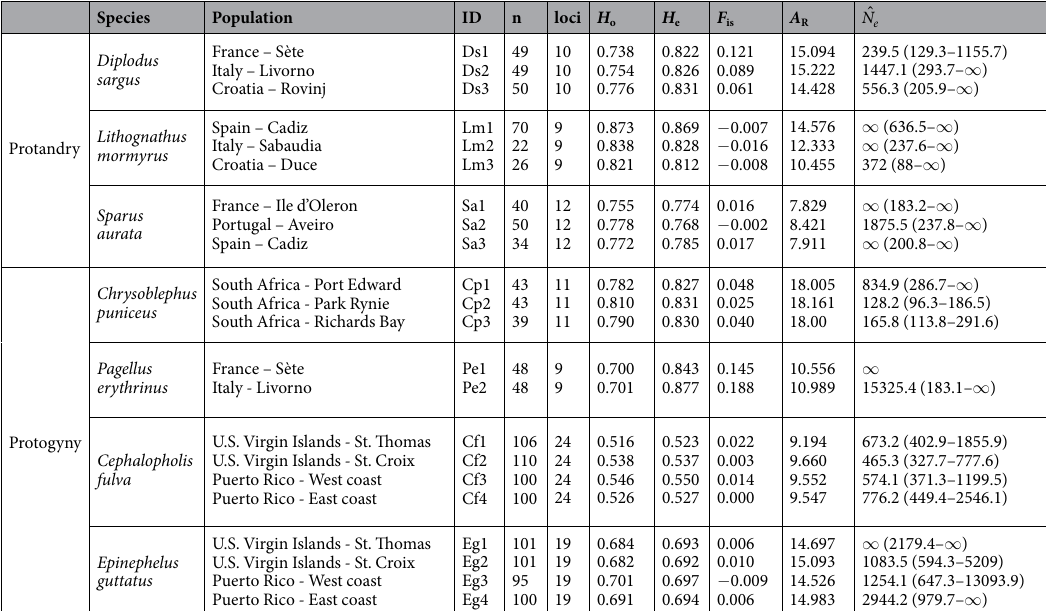
Table 3. Genetic diversity parameters (n = sample size; loci = number of microsatellite loci) for multiple populations (with relative ID) of each species. H o = observed heterozygosity; H e = expected heterozygosity; F is = coefficient of inbreeding; A R = allelic richness. Effective population size ( ˆ N